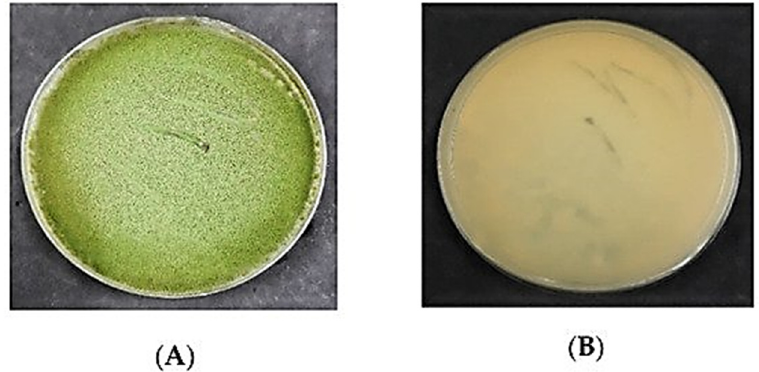
Figure 3. Colony morphology of A. flavus on the potato dextrose agar (PDA); ( A ) = obverse, ( B ) = reverse. ( B ) = reverse.